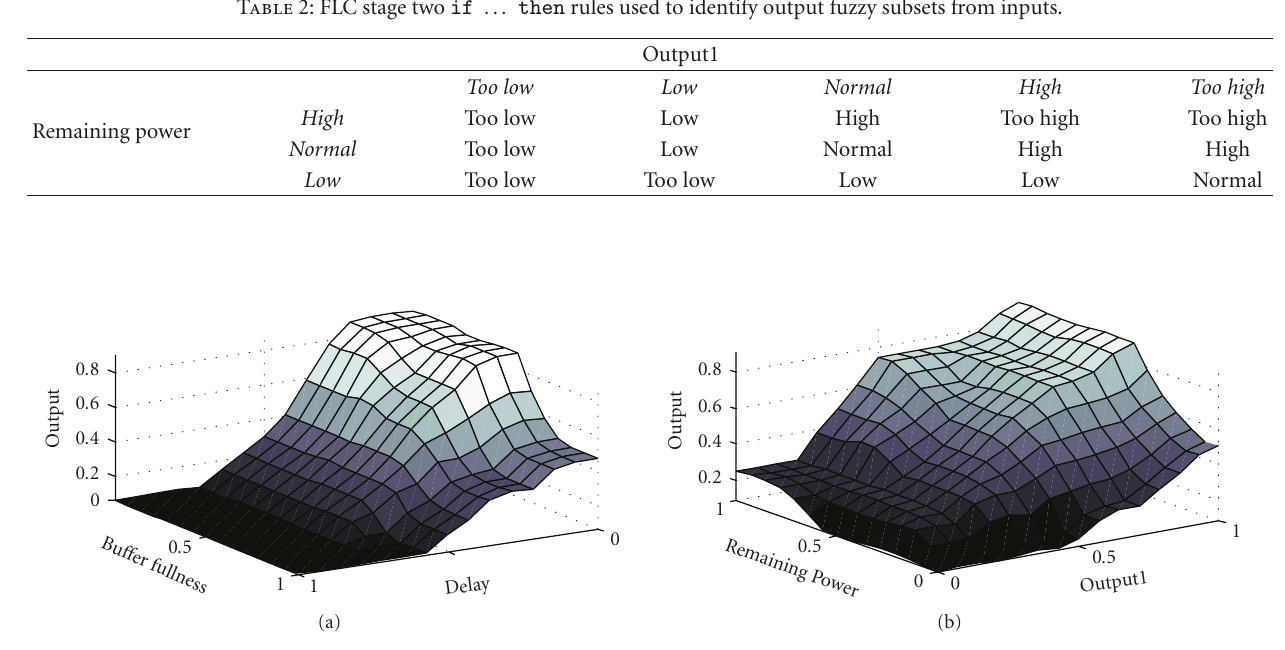
Figure 4: (a) Stage one, FLC control surface resulting from FLC ARQ; (b) stage two, control surface giving the transmission count output (before subsequent